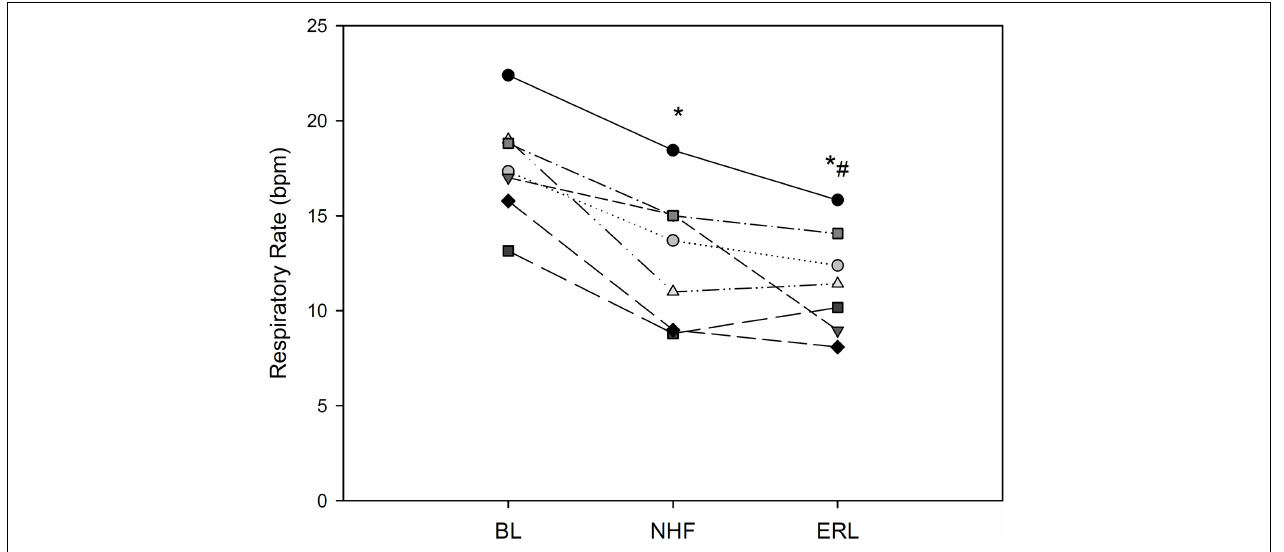
FIGURE 3 | Respiratory rate in each of 8 COPD patients; BL, baseline; NHF, nasal high flow cannula; and ERL, expiratory resistive loading. * p < 0.05 vs. BL, # p < 0.05 vs. NHF.